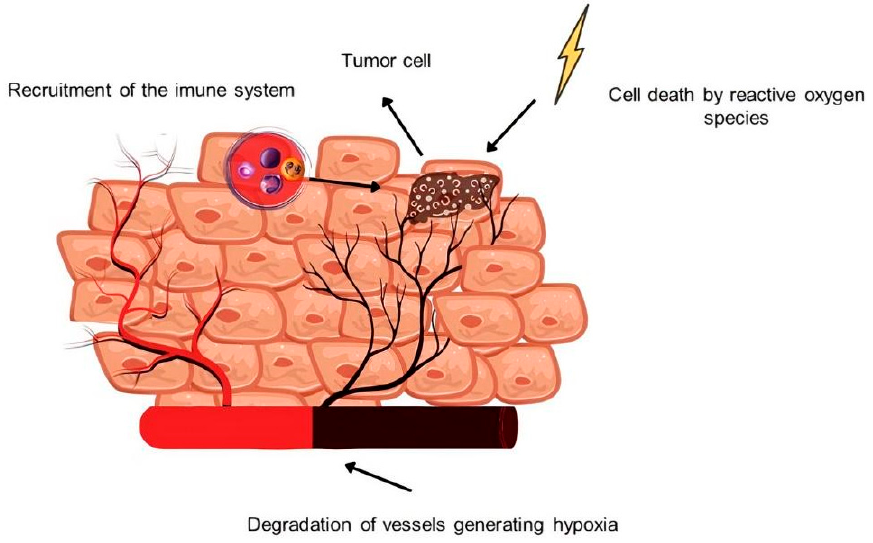
Figure 1. Three different mechanisms of PDT to combat tumor cells, being the process of direct cytotoxicity, inflammatory processes modulated by activation of the immune response, and hypoxia by vessel occlusion. Source: Authors.